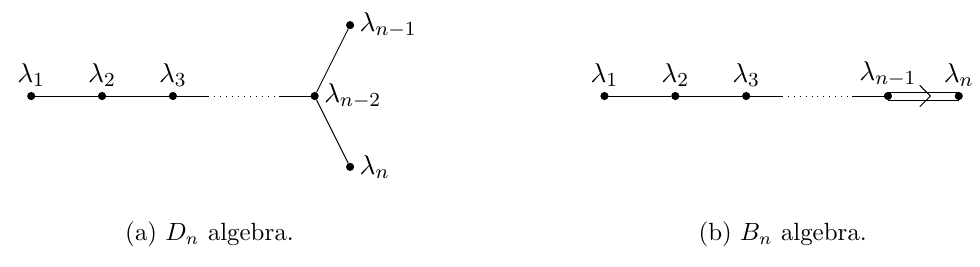
Figure 1. Dynkin diagrams of so ( d )